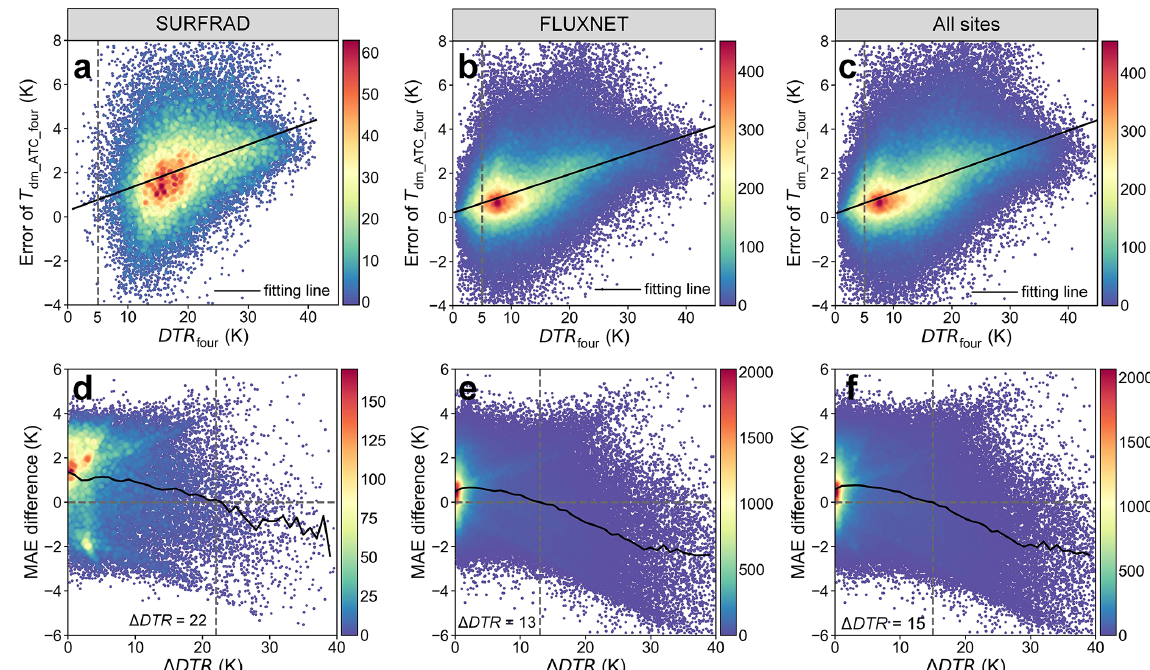
Figure 11. Threshold determination for the two criteria in Fig. 2. Panels (a) , (b) , and (c) display the errors of T dm_ATC_four ( T dm_ATC_four minus T dm_true ) depending on DTR four for SURFRAD, FLUXNET, and combined data, respectively; and panels (d) , (e) , and (f) display the MAE differences between T dm_ATC_four and T dm_ATC_DTC (i.e., the MAE of T dm_ATC_four minus the MAE of T dm_ATC_DTC ) depending on the (cid:49) DTR for SURFRAD, FLUXNET, and combined data, respectively. The black lines in (d) , (e) , and (f) denote the averaged MAE difference within every unit along the x